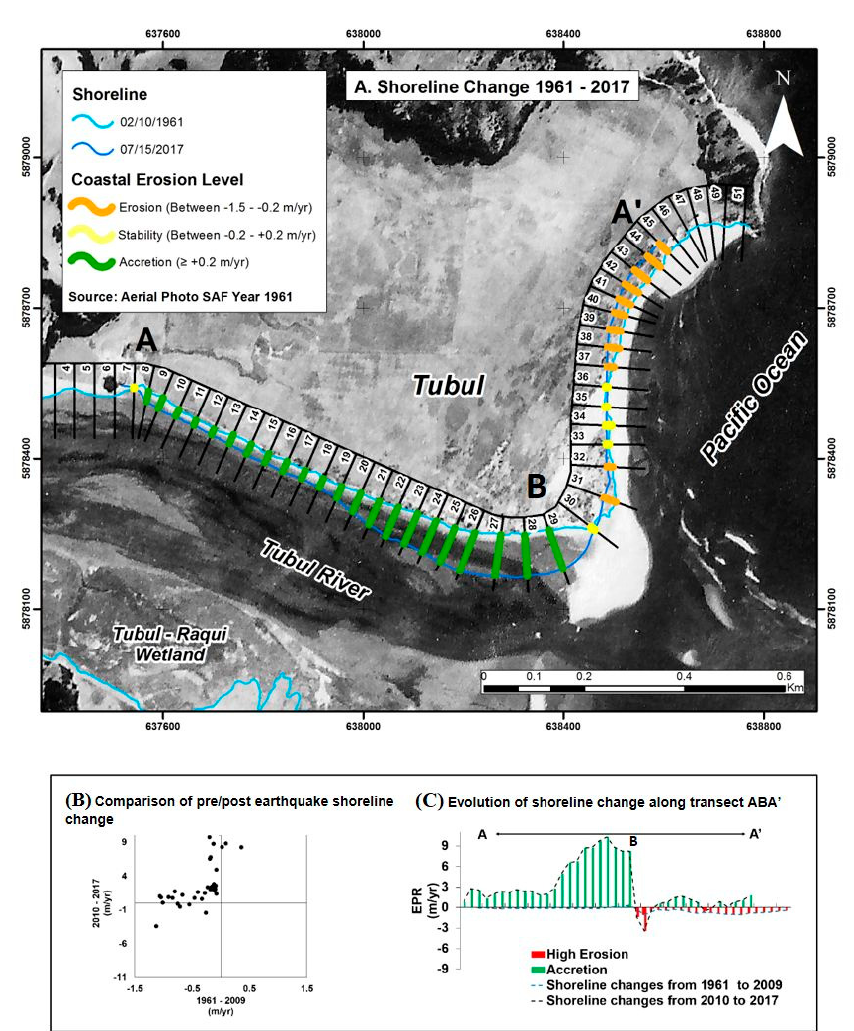
Figure 4. ( A ) Average change rate (m/year) of the shoreline in two segments of the estuarine zone of the Tubul River, considering a period of 36 years (1961–2017). Green lines indicate accretion, yellow lines indicate stability, orange lines indicate moderate erosion, and red lines indicate strong erosion. In segment 1 (BA’), or marine zone, an erosive process was observed, with erosion values between − 1.5 and − 0.2 m/year recorded. Meanwhile, in segment 2 (AB), or estuarine zone, an initial accumulation of sediment was measured, with an average accretion rate of ≥ 0.2 m/year. ( B ) This erosive trend in the marine zone constitutes a continual process in the analyzed time period, which, although decreased in magnitude as a result of the coastal uplift induced by the 27 February earthquake, was not reversed. ( C ) Along the ABA’ transect the differentiated behavior of the coastline is observed, exposed to the dominance of the waves (A’-B) and to the tides (river-sea) (B-A)